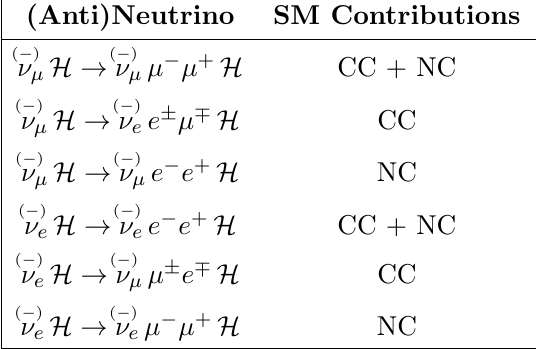
Table 1 . (Anti)Neutrino trident processes considered in this